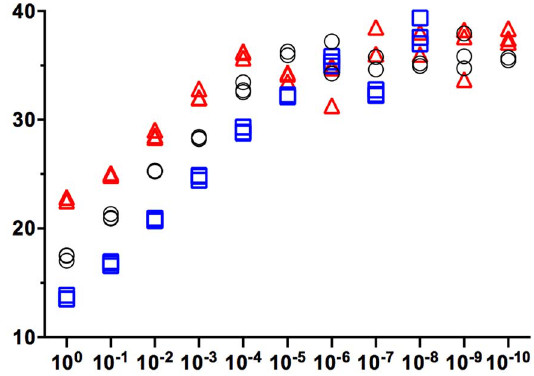
Figure 7. Cp (crossing point) vs. serial dilutions for chicken (black circle), Canissp. (blue square) and human (red triangle) assays in triplicate.